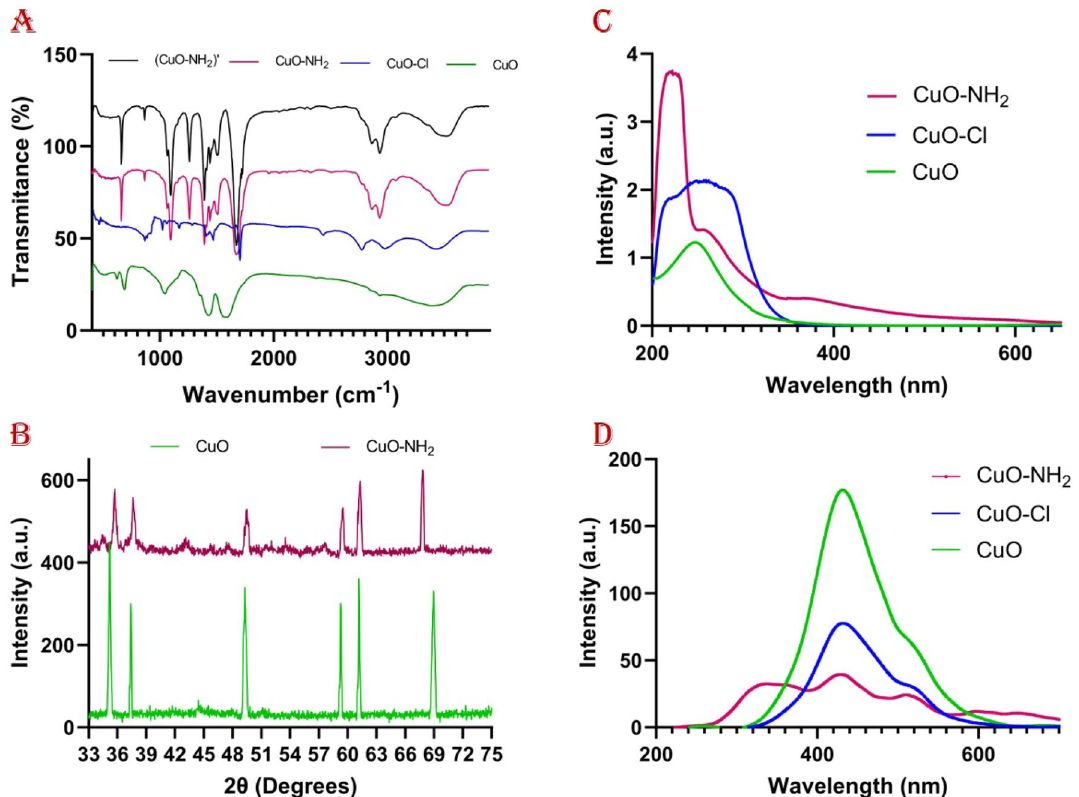
Figure 2. ( A ) The FT-IR spectra, ( B ) the PXRD, ( C ) the UV–Vis spectra, and ( D ) the photoluminescence spectra of prepared